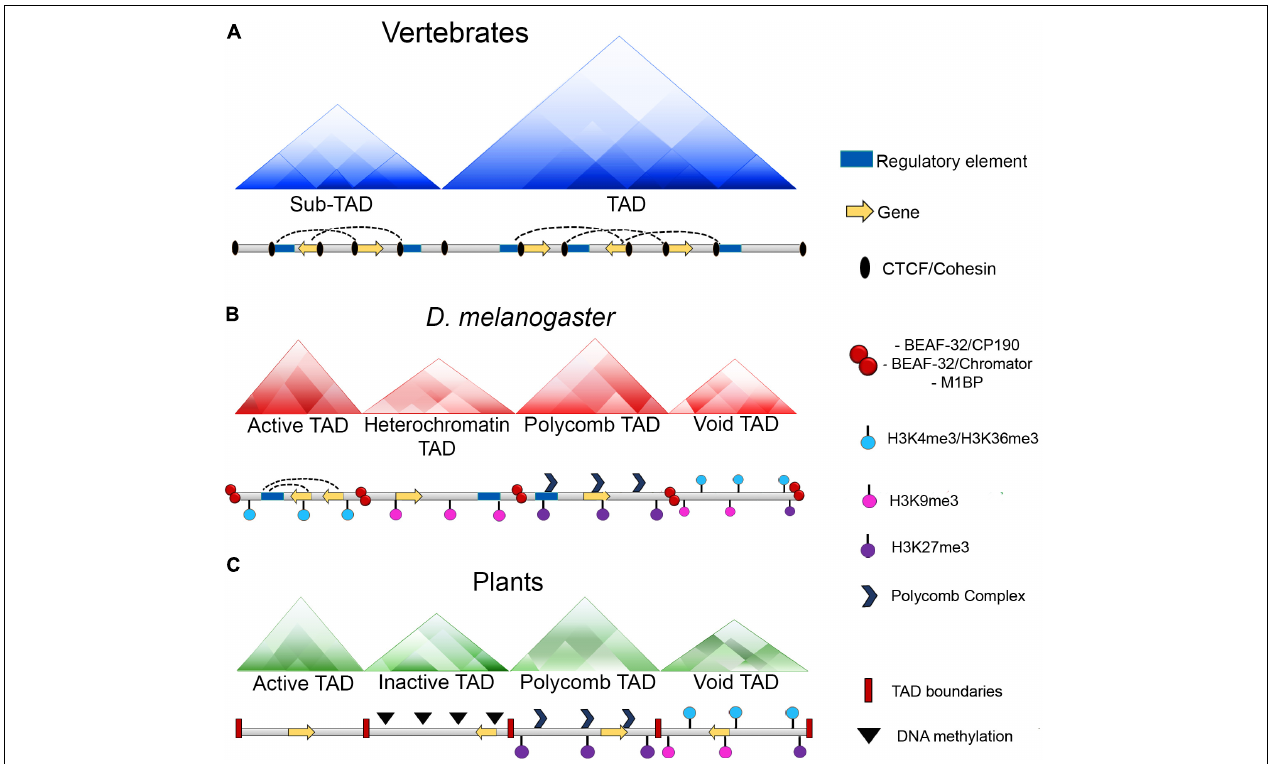
FIGURE 2 | Chromatin organization among different organisms. (A) In vertebrates, chromatin loops are formed and stabilized by the presence of CTCF and the cohesin complex. Moreover, TAD boundaries present an enrichment of CTCF and the cohesin complex which act as insulators and keep these domains detached. (B) In Drosophila , chromatin loops exist, however, there is not an enrichment of the dCTCF ortholog with the cohesin complex at the boundaries of these domains, instead, this role it is carried out by other architectural proteins of the fly as BEAF-32, CP190, chromator or M1BP. Additionally, in Drosophila TADs can be classified according to their epigenetic states: Active TADs which possess an enrichment of active histone marks as H3K4me3 and H3K36me3; heterochromatin TADs which have an enrichment of repressive marks as H3K9me3; Polycomb TADs which are enriched with the presence of Polycomb complexes and the H3K27me3 mark and void TADs which do not have a defined landscape. (C) In plants, CTCF is not conserved and there is not a report of any protein with insulator activities. However, the existence of TAD-like domains has been reported and as well as Drosophila, these domains can be classified in four distinct categories which are: Active TADs; inactive TADs characterized by a high degree of DNA methylation; Polycomb TADs and void